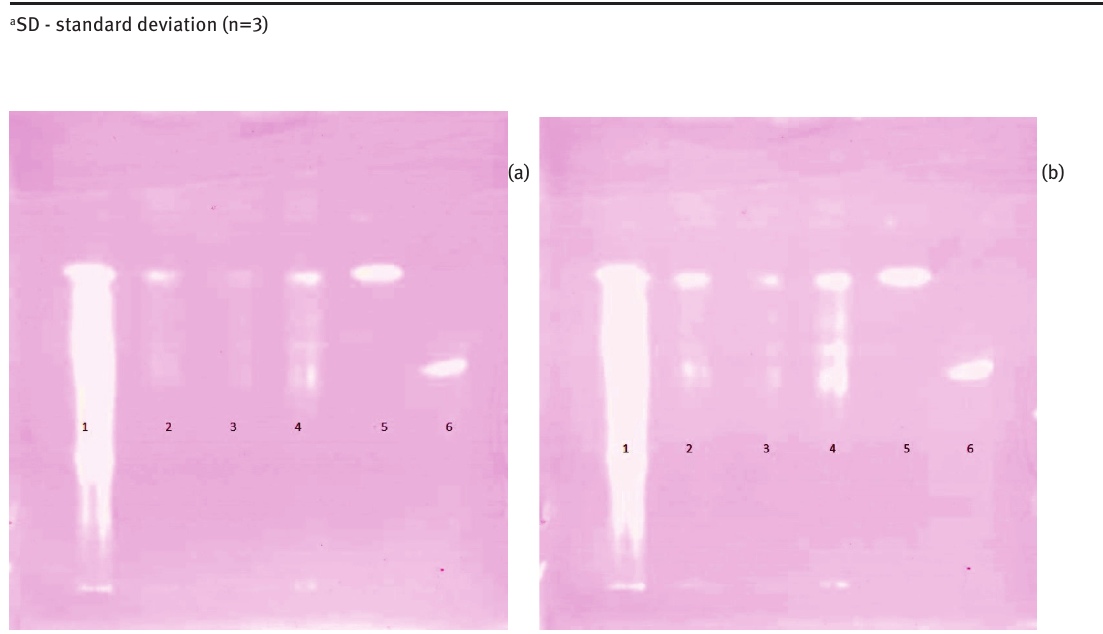
Figure 1: HPTLC the analysed extracts. System: silica/acetonitrile:water:chloroform:formic acid (60:15:10:5, v/v/v/v). Plates after development dried (30 min) and derivatised by immersion in 0.2% (w/v) DPPH • solution in chloroform, kept in the dark (30 min) and then scanned (after 15 min – 1a , and 30 min – 1b ). 1 – extract of linden inflorescence (200 mg mL -1 ), 2, 3, 4 – extract of gruels with addition 10, 5 and 20% of linden inflorescence respectively (200 mg mL -1 ), 5 – caffeic acid (0.5 mg mL -1 ), 6 – rutin (0.5 mg mL -1